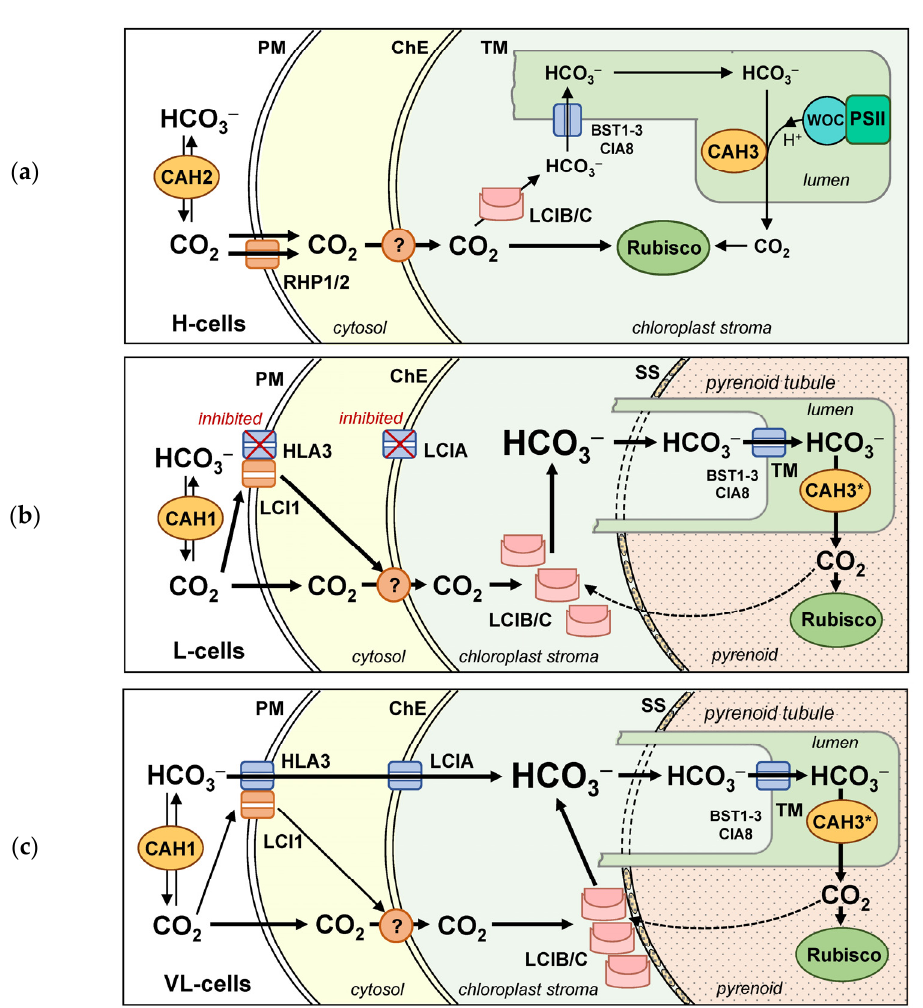
Figure 8. Schematic of photosynthetic C i assimilation in C. reinhardtii under different CO 2 supply. ( a ) H-cells growing under conditions of elevated CO 2 concentrations (2–5%), with inactive CCM; Generalized model of CCM functioning in C. reinhardtii cells grown at: ( b ) low (0.03–0.5%; L cells) and ( c ) very low (<0.02%; VL cells) CO 2 concentrations. The scheme shows bicarbonate entry into the lumen of intrapyrenoid thylakoids (pyrenoid tubules) from minitubules in L- and VL-cells, and does not take into account the participation of transporters located on membranes on the stroma side. Abbreviations: ChE—chloroplast envelope; PM—plasma membrane; SS—starch sheath; TM—thylakoid membrane; CAH3*, activated enzyme. The preferential pathways of C i fl uxes in the corresponding acclimation state of the cell are shown in bold.